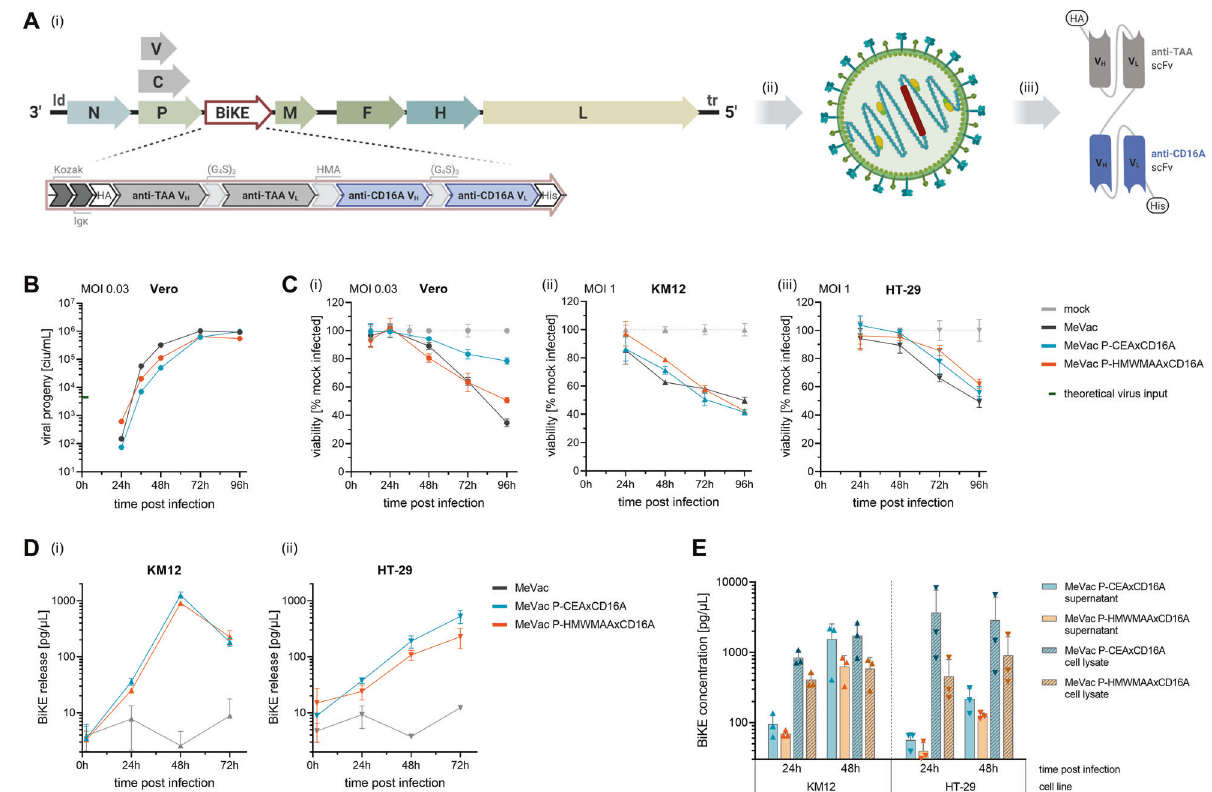
Fig. 2 Oncolytic measles virus encoding BiKEs. A Schematic of recombinant MV-BiKE. (i) The BiKE transgene is encoded downstream of the P open reading frame within the MV genome. Hemagglutinin (HA) and hexa histidine (His 6 ) tags enable puri fi cation and detection. Kozak and Ig κ leader sequences mediate ef fi cient translation and secretion. (G 4 S) 3 , glycine-serine peptide linker; HMA, human muscle aldolase linker; scFv, single chain variable fragment with variable heavy (V H ) and variable light (V L ) chain; TAA, tumor-associated antigen. (ii) Transgene- encoding virus can be rescued via a reverse genetics system and triggers (iii) BiKE secretion upon infection. BiKEs included in this study target either human carcinoembryonic antigen (CEA) as model tumor antigen or human high molecular weight melanoma-associated antigen (HMWMAA) as a non-relevant control. B Replication kinetics of MV-BiKE. Vero producer cells were inoculated with MeVac P-BiKE or unmodi fi ed MeVac at MOI 0.03. Viral progeny at designated time points were determined via serial dilution titration assay to obtain a multistep growth curve. C Direct cytotoxic effect of MV-BiKE. Cells were infected with respective viruses at MOI 0.03 for Vero (i) or at MOI 1 for colorectal cancer cell lines KM12 (ii) and HT-29 (iii). Cell viability was determined via XTT assay and normalized to mock-infected control. D , E BiKE expression kinetics on infected colorectal cancer cells. KM12 and HT-29 cells were inoculated with MeVac P-BiKE or MeVac at MOI 1. Supernatants and cell lysates were collected at indicated time points. BiKE concentrations were determined via ELISA using anti-His 6 and anti-HA antibodies and puri fi ed vBiKEs as standard. D Kinetics of BiKE concentrations in culture supernatants after infection with MV-BiKE. E Concentrations of cell- associated BiKE in tumor cell lysates and BiKE release into culture supernatants. In C – E mean values of technical triplicates are shown. Error bars indicate